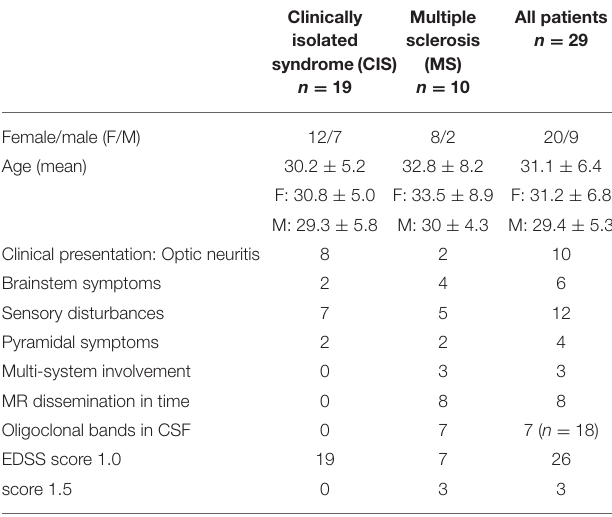
TABLE 1 | The demographic and clinical characteristics of the study